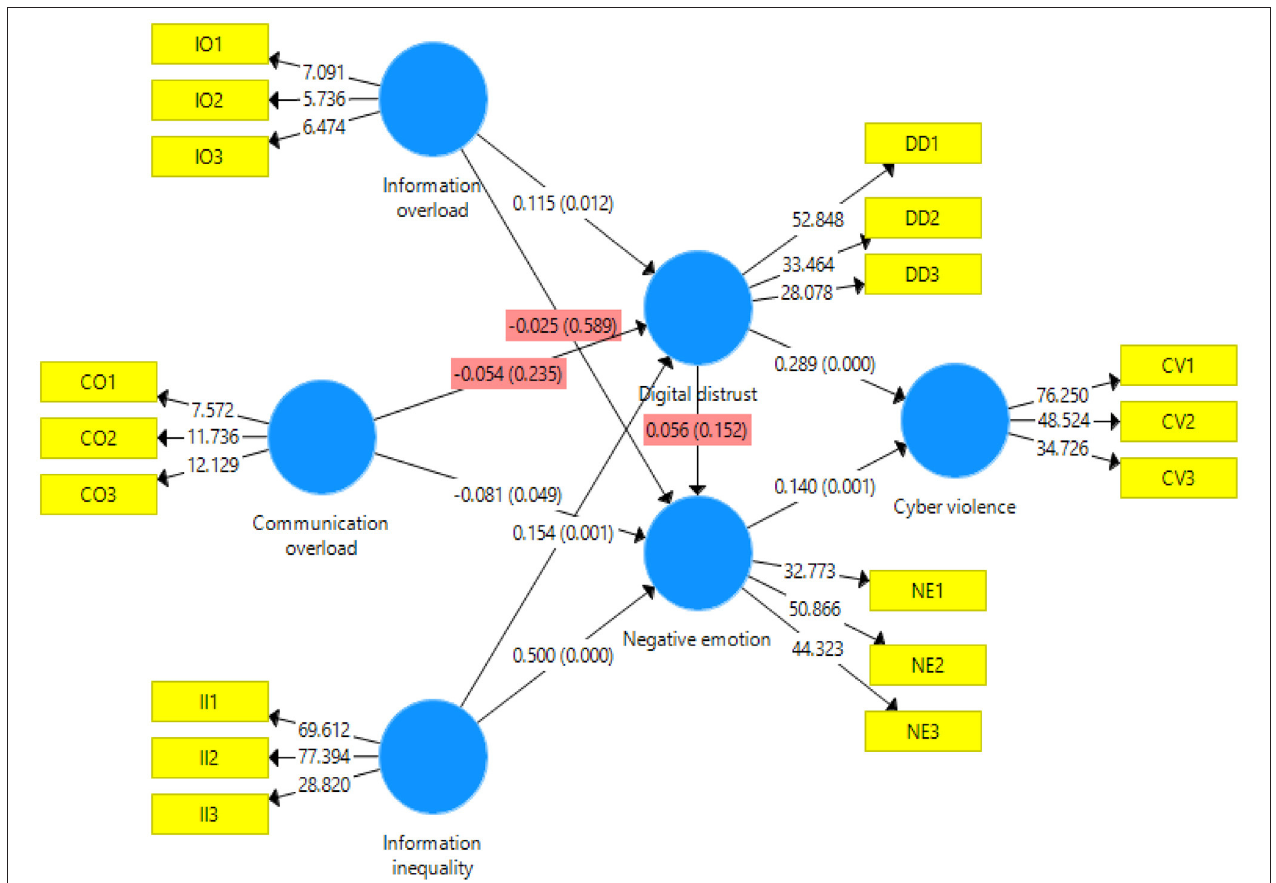
FIGURE 2 | Structural equation